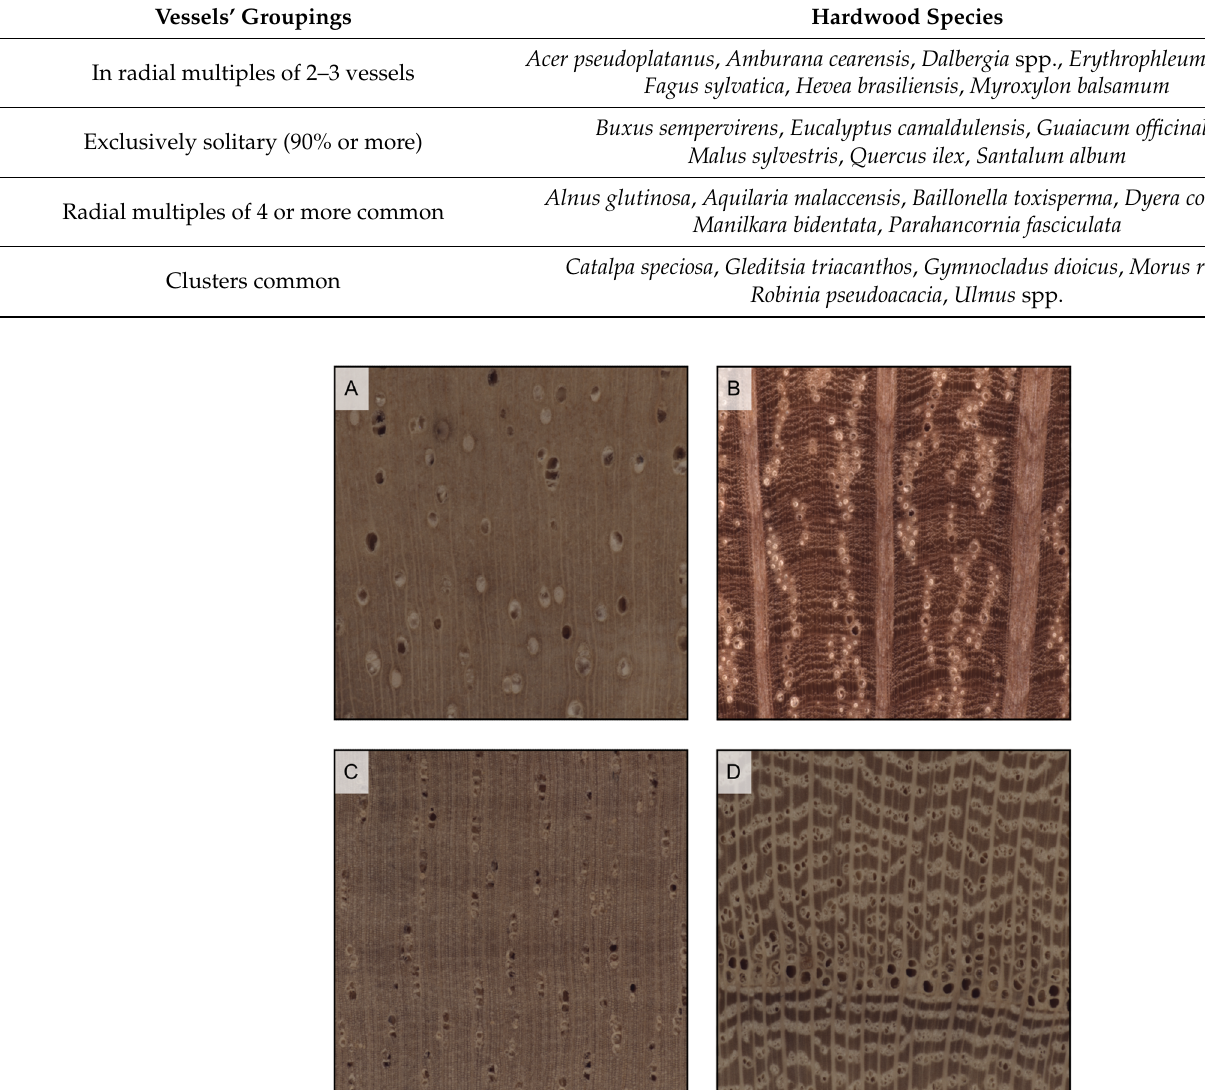
Table 13. Examples of species for different types of vessels’ groupings.